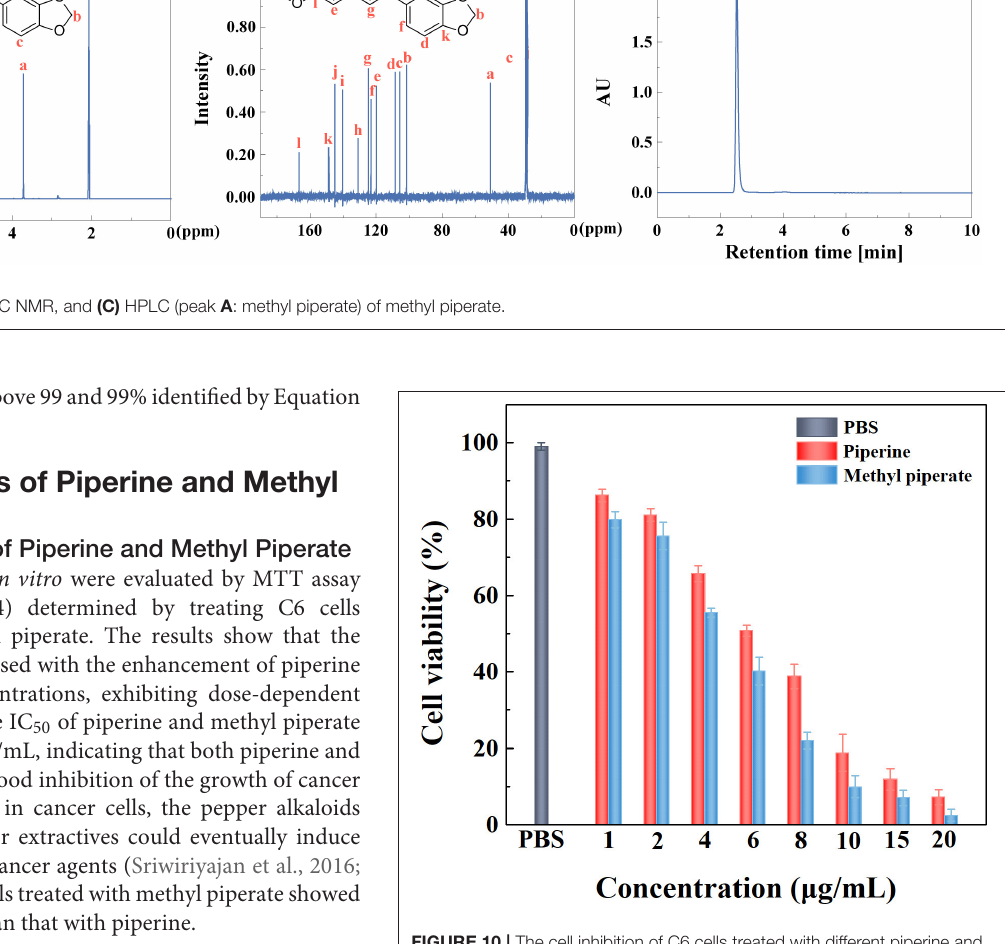
FIGURE 10 | The cell inhibition of C6 cells treated with different piperine and methyl piperate concentrations.